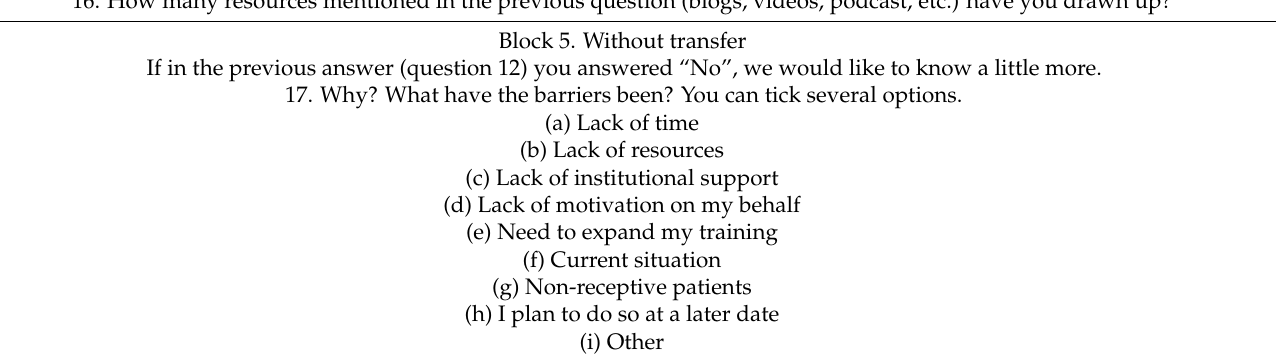
Block 4. Positive